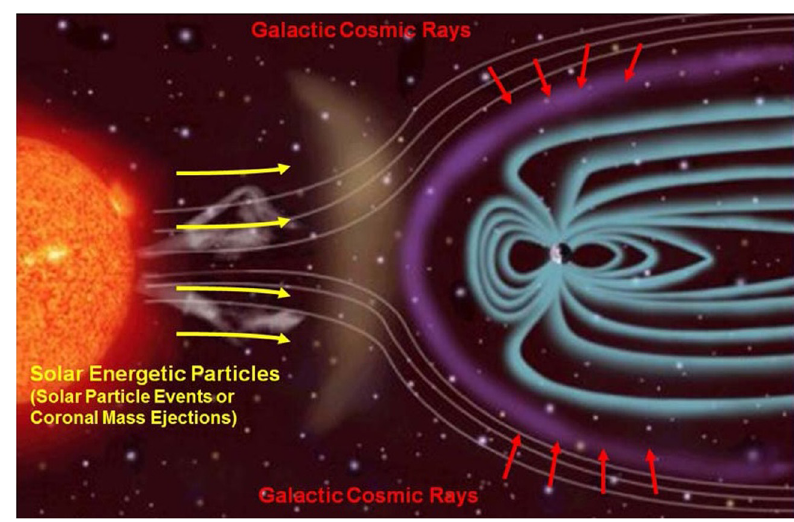
Figure 3: The two main radiation types are monitored by the radiation assessment detector and how the magnetic fi eld around the Earth a ff ects the radiation in near - Earth space. Figure courtesy of NASA/JPL -